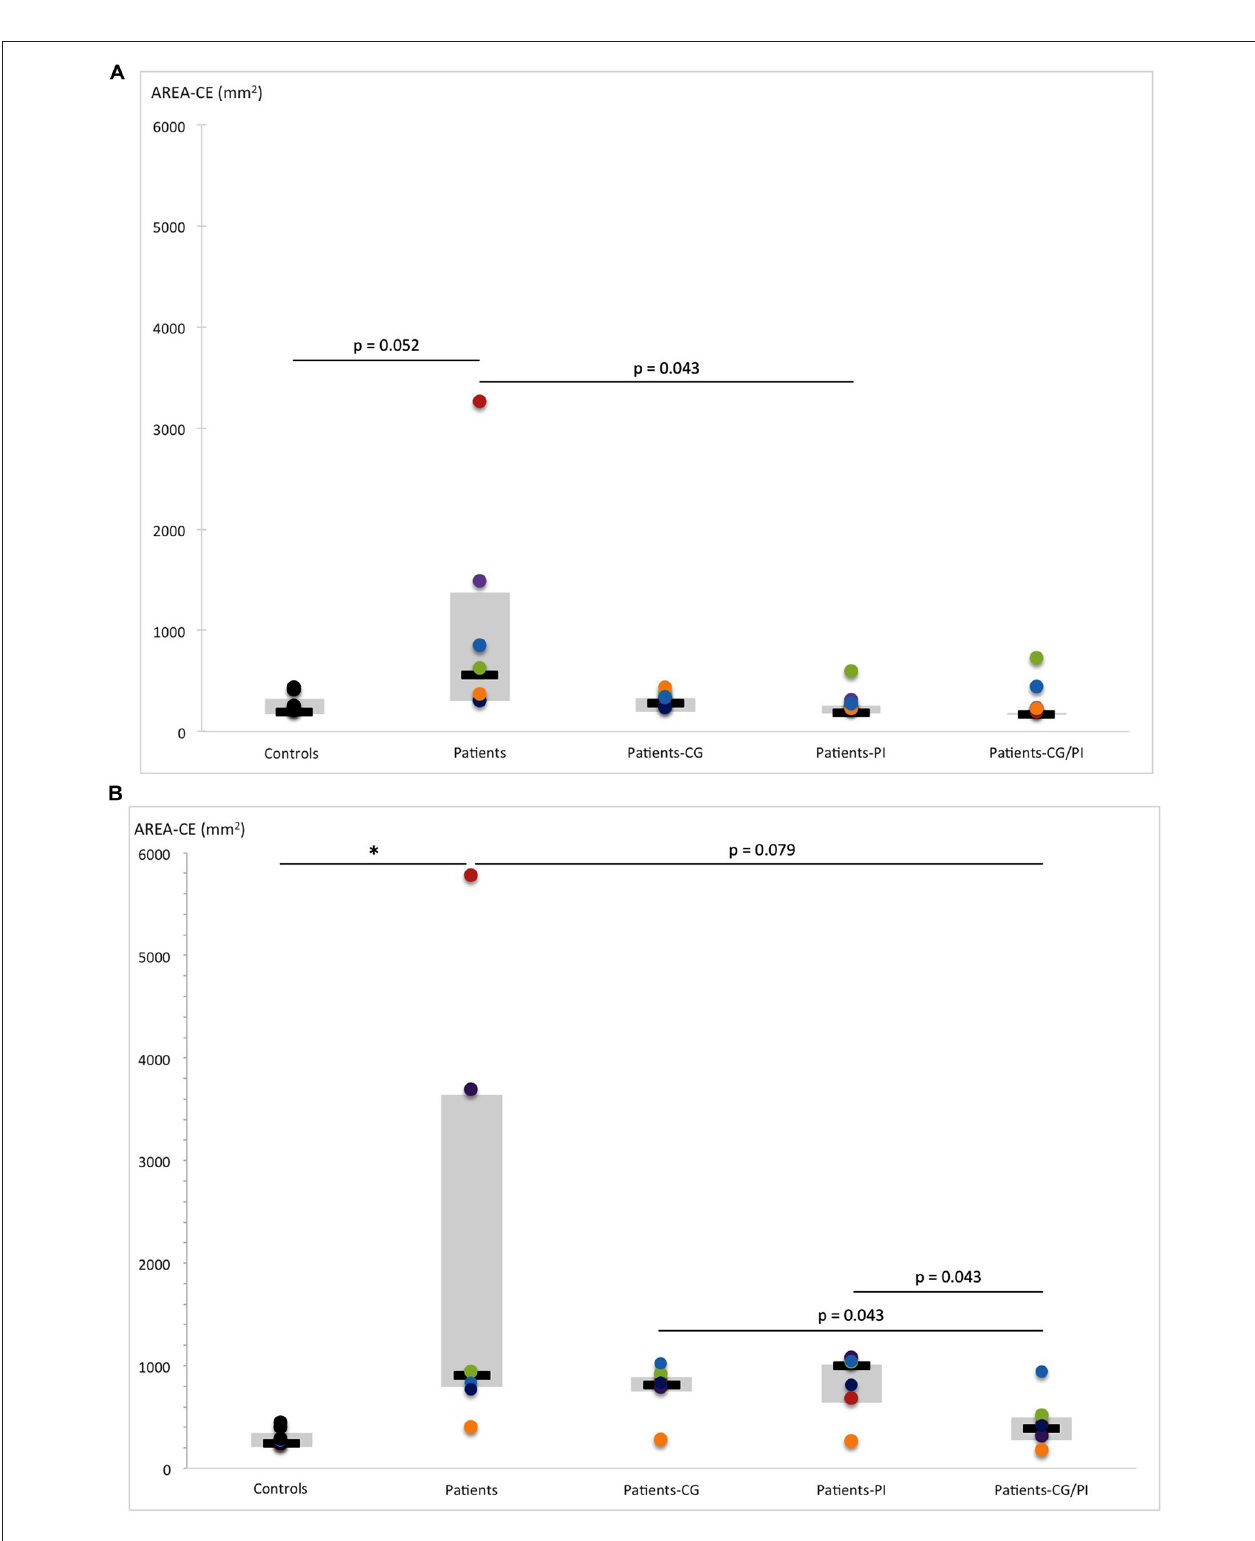
FIGURE 4 | Comparison of AREA-CE (area of 95% confidence circumference, mm 2 ) obtained by hEDS patients and controls, with and without somatosensory orthoses (CG, compression garments; PI, proprioceptive insoles; CG-PI, both somatosensory orthoses): in (A) eyes-open, and (B) eyes-closed conditions. Box plots represent median and quartiles, and dots represent performance of each participant as follows: controls: black; patient 1: red; patient 2: green; patient 3: purple; patient 4: light blue; patient 5: orange; patient 6: dark blue. ∗ p < 0.05.